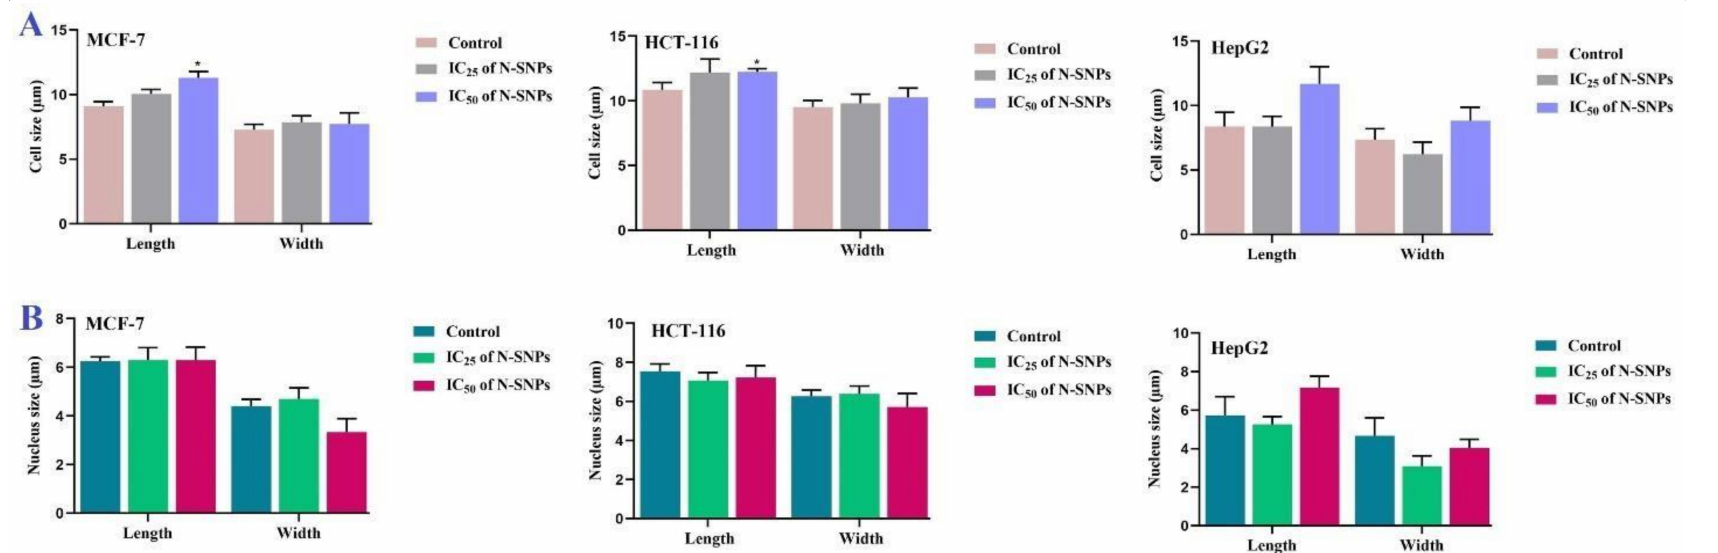
Figure 9. Morphometric analysis ( µ m) of ( A ) cell size (length and width) and ( B ) nucleus size (length and width) of MCF-7, HCT-116, and HepG2 cells before and after treatment with N-SNPs at IC25 and IC50. Data represent averages of measurements of 10 cells and they are presented as mean ± SEM. p -values were calculated versus untreated cells: * p <